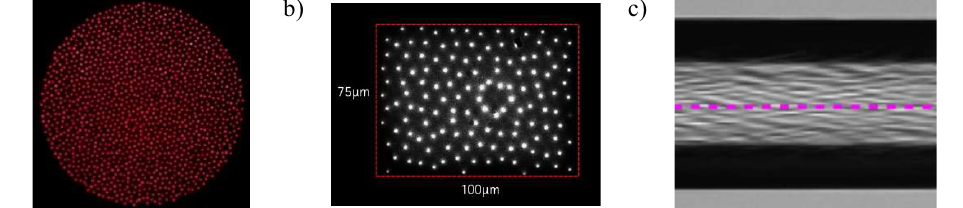
Fig. 1: (a): The 1281 cores of the aperiodic multicore fiber (b): Structured illumination did not indicate any substantial cross-talk. (c): Side view of the twisted fiber with a twist period of 2.5 cm -1